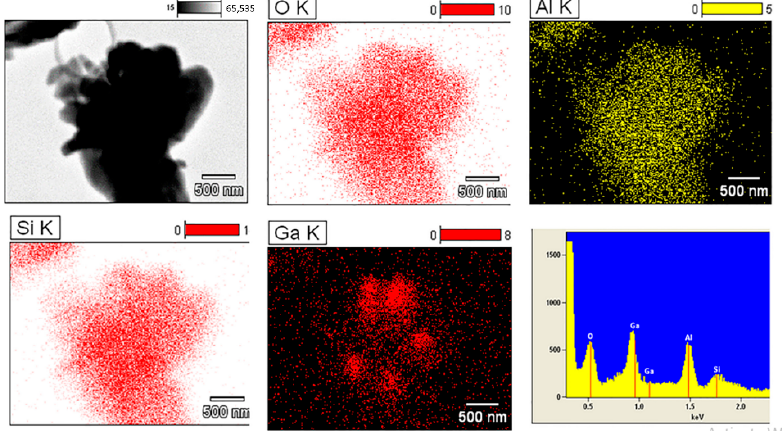
Figure 8. TEM image of Ga deposited on mordenite zeolite (Ga@mordenite) with elemental mapping (O, Al, Si, Ga) and EDS plot. Adapted with permission from Wiley-VCH [65].